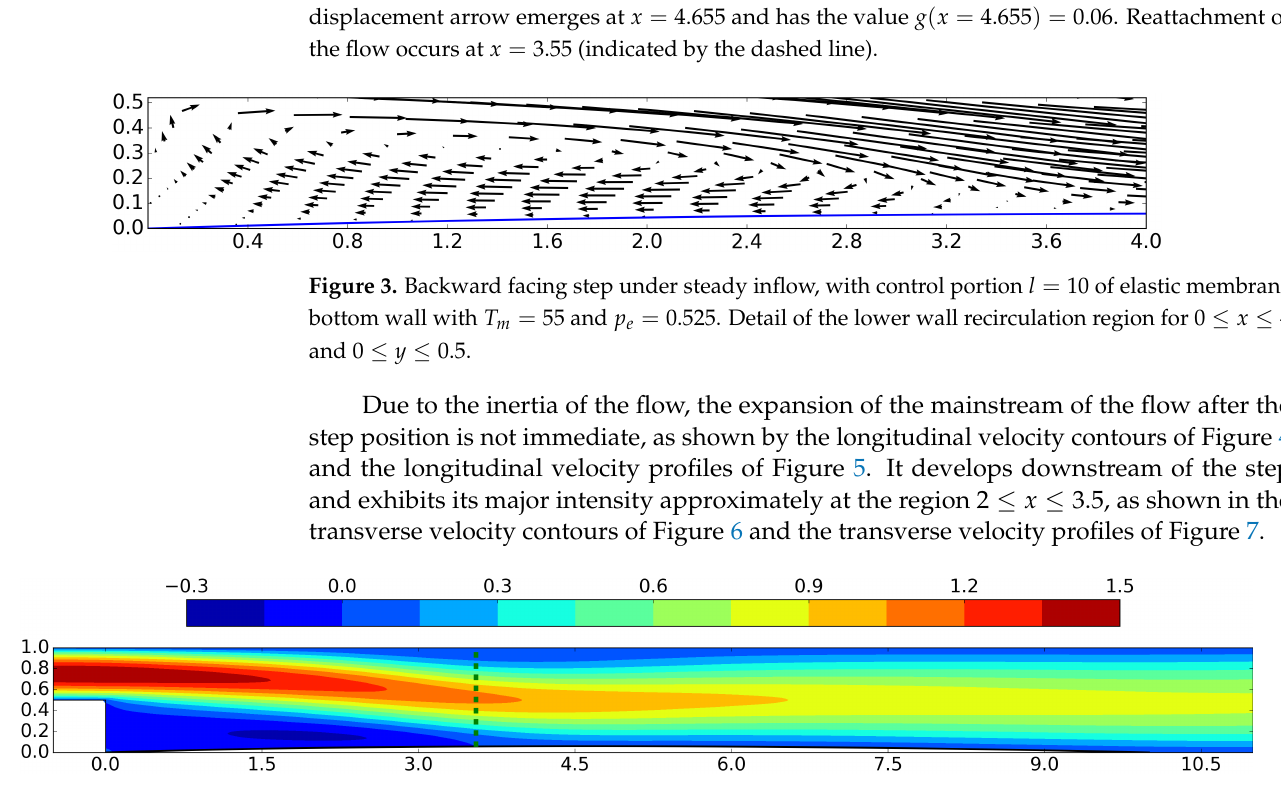
Figure 4. Backward facing step under steady inflow, with control portion l = 10 of elastic membrane bottom wall with T m = 55 and p e = 0.525. Longitudinal velocity contour plot for − 0.5 ≤ x ≤ 11. The lower reattachement position is emphasized by the dashed